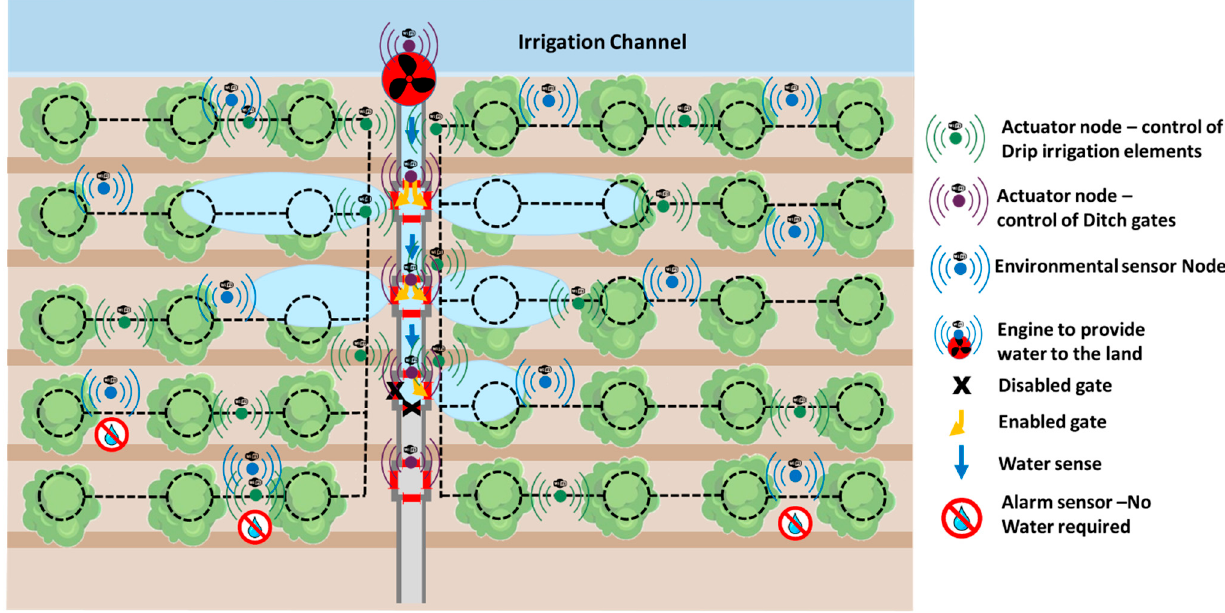
Figure 10. Diagram of our entire network in the plot.